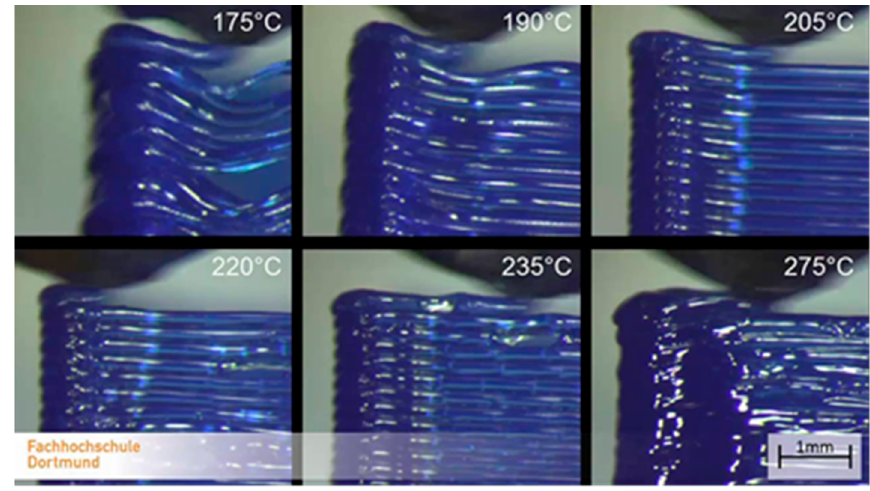
Figure 15. The temperature effect on the model [43].